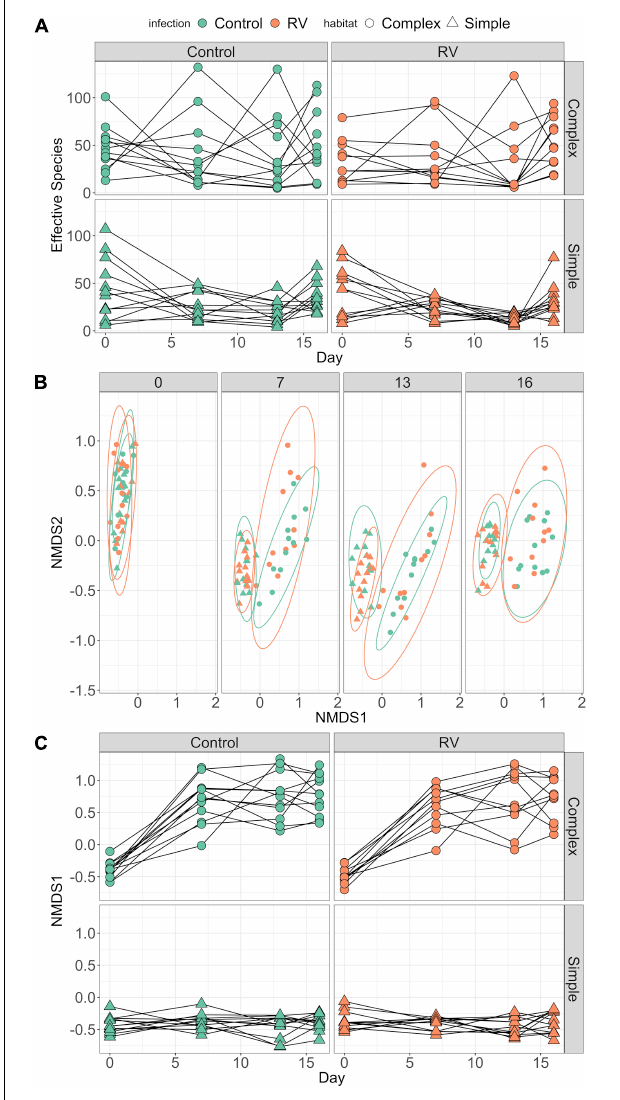
FIGURE 3 | Dynamics of frog skin bacterial communities over time. (A) Trends over time in bacterial alpha diversity (effective number of species) depending on Habitat treatment (rows) and pathogen exposure (columns). Dynamics of alpha diversity over time were significantly different in Complex habitats. When marginalizing the effects of time (day), individuals in Complex habitats possessed higher bacterial species richness compared to individuals in Simple habitats (see Supplementary Figure S2 ). (B) Trends over time in bacterial community structure (beta diversity). Individuals were exposed to ranavirus or control between days 13 and 16, but points are colored by disease treatment at all time points to allow tracking of beta diversity over time for different groups. (C) Temporal trends in primary axis of NMDS ordination (beta diversity) depending on Habitat treatment (rows) and pathogen exposure (columns). As with (A) , there was strong support in the data for an interaction between day and habitat on beta diversity trajectories over